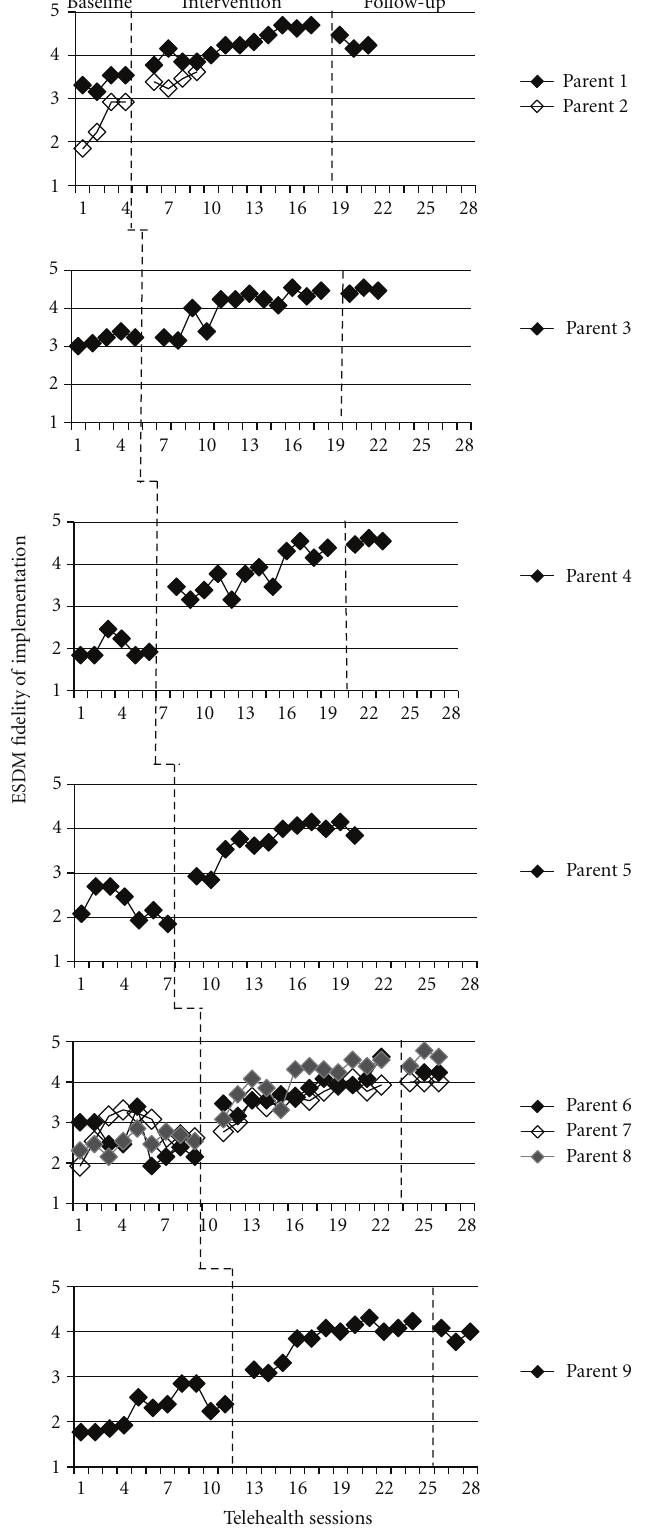
Figure 2: Individual parent ESDM fidelity